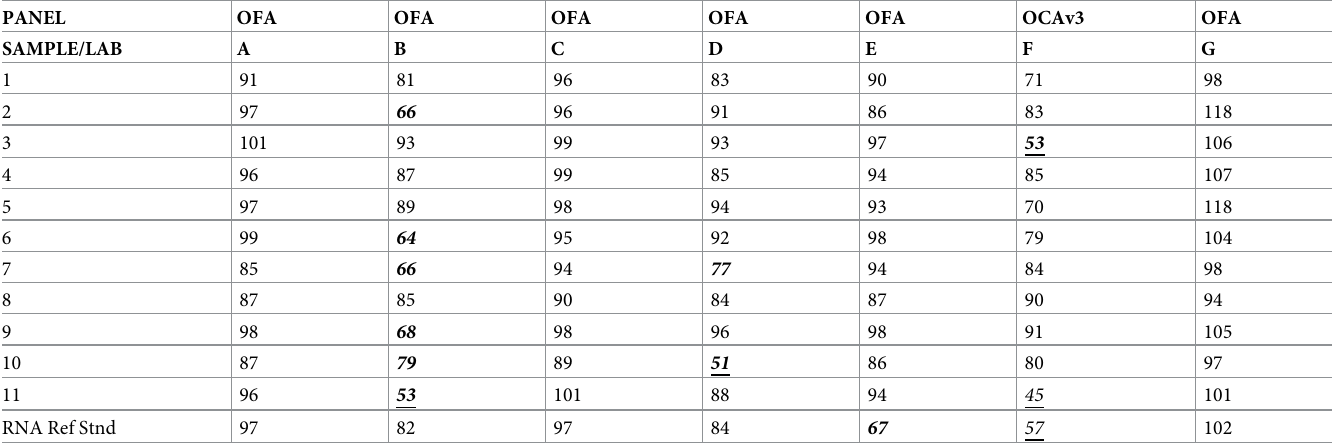
Table 5. Phase 1 RNA read length values.